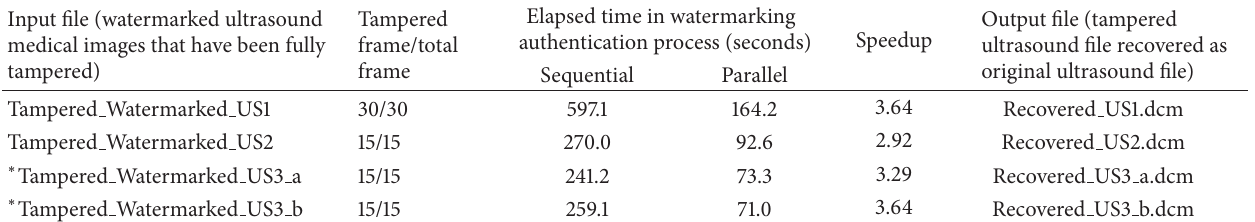
Table 7: Sequential versus parallel watermarking authentication process in elapsed time.